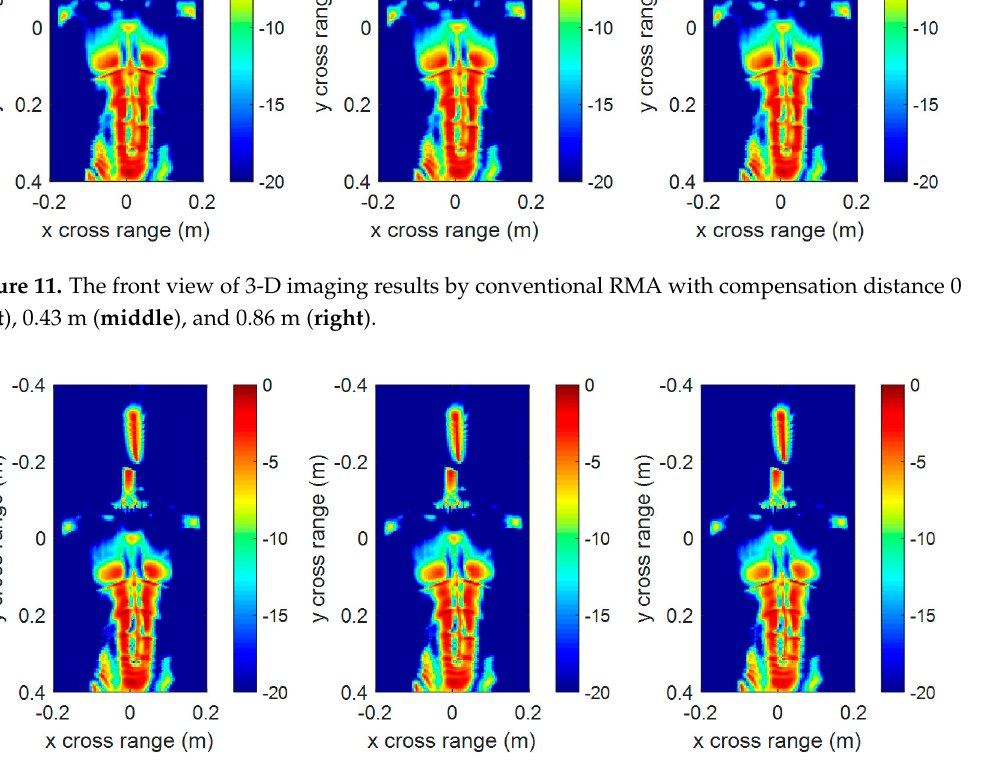
Figure 12. The front view of 3-D imaging results by conventional RMA with compensation distance 0 ( left ), 0.43 m ( middle ), and 0.86 m ( right ).